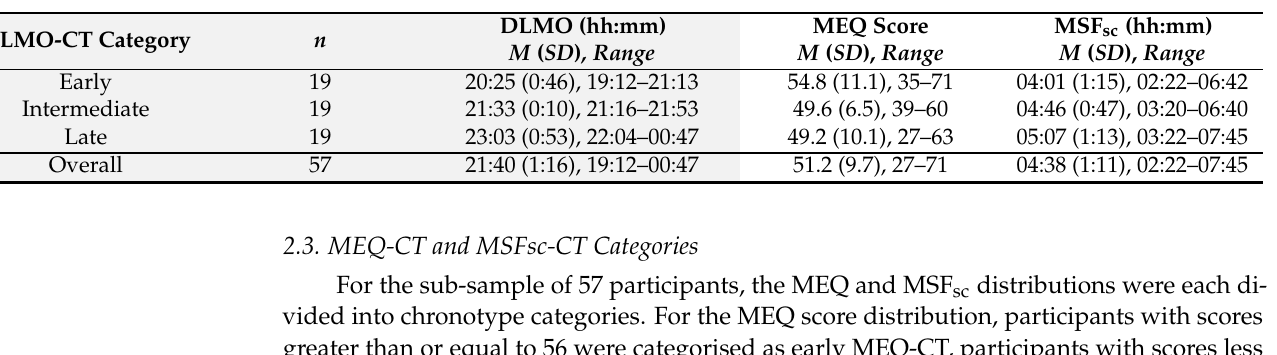
Table 1. Means, standard deviations, and ranges of DLMO, MEQ Score and MSF sc for early, intermediate and late DLMO-CT categories.